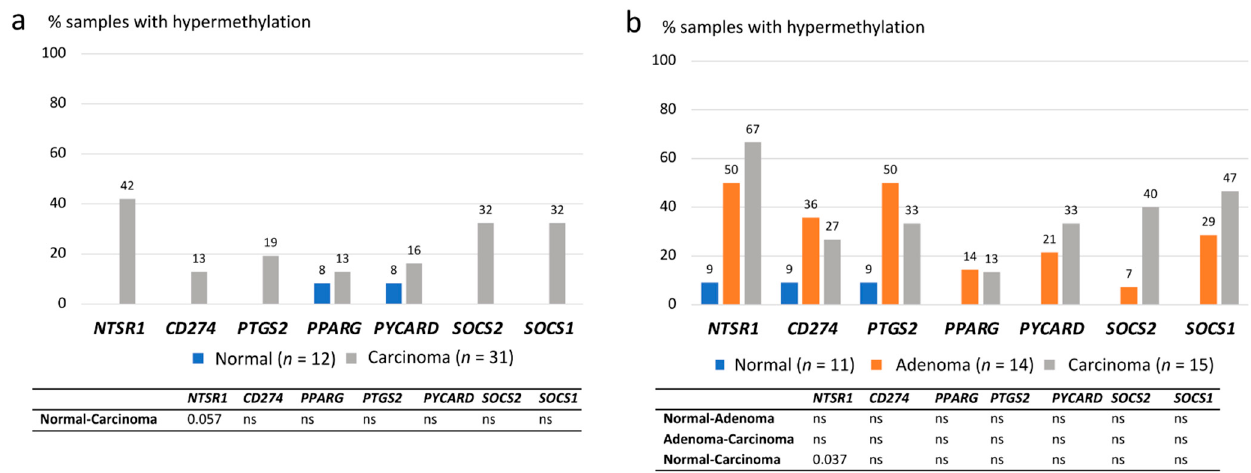
Figure 4. Hypermethylation frequencies of inflammation-associated genes. ( a ) Hypermethylation frequencies in CA-CRC samples. ( b ) Hypermethylation frequencies in LS-associated samples. Bonferroni-corrected two-sided p values are presented in the tables below for pairwise comparisons, and ns stands for non-significant p value. Missing frequency values of the normal sample group indicate the hypermethylation frequency of 0%.